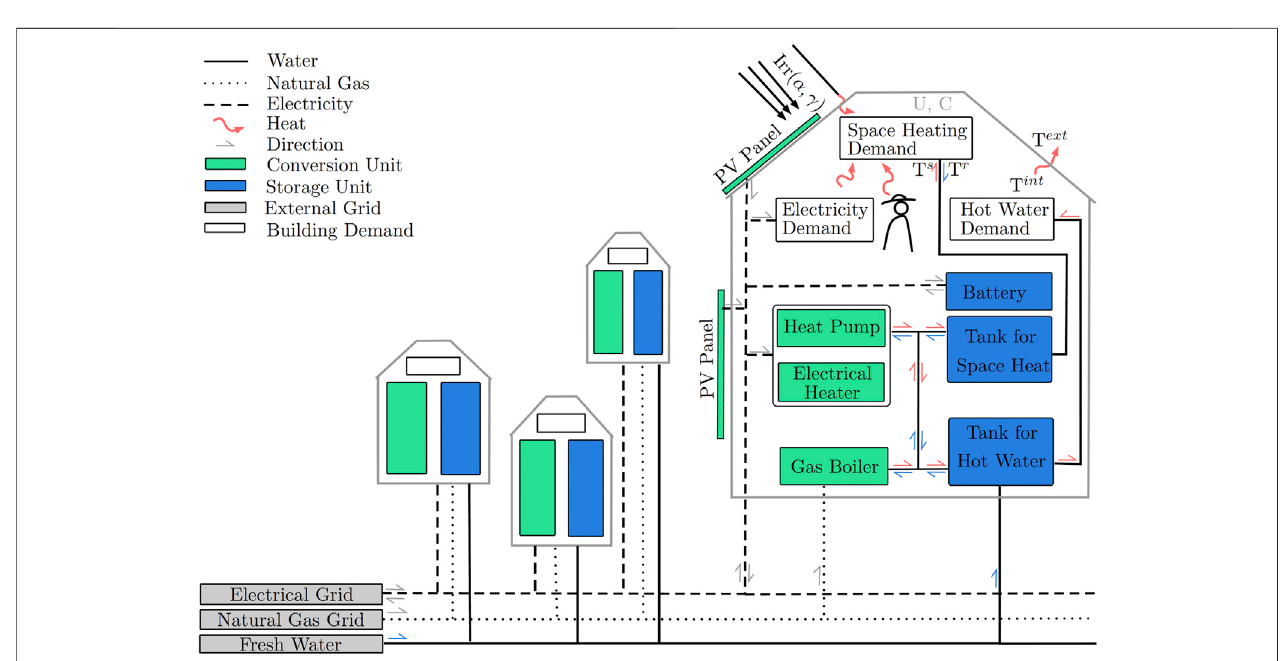
FIGURE 1 | Overview of the district energy system. U , C : building heat transfer and capacity factor, Irr : irradiation, and T : temperatures.